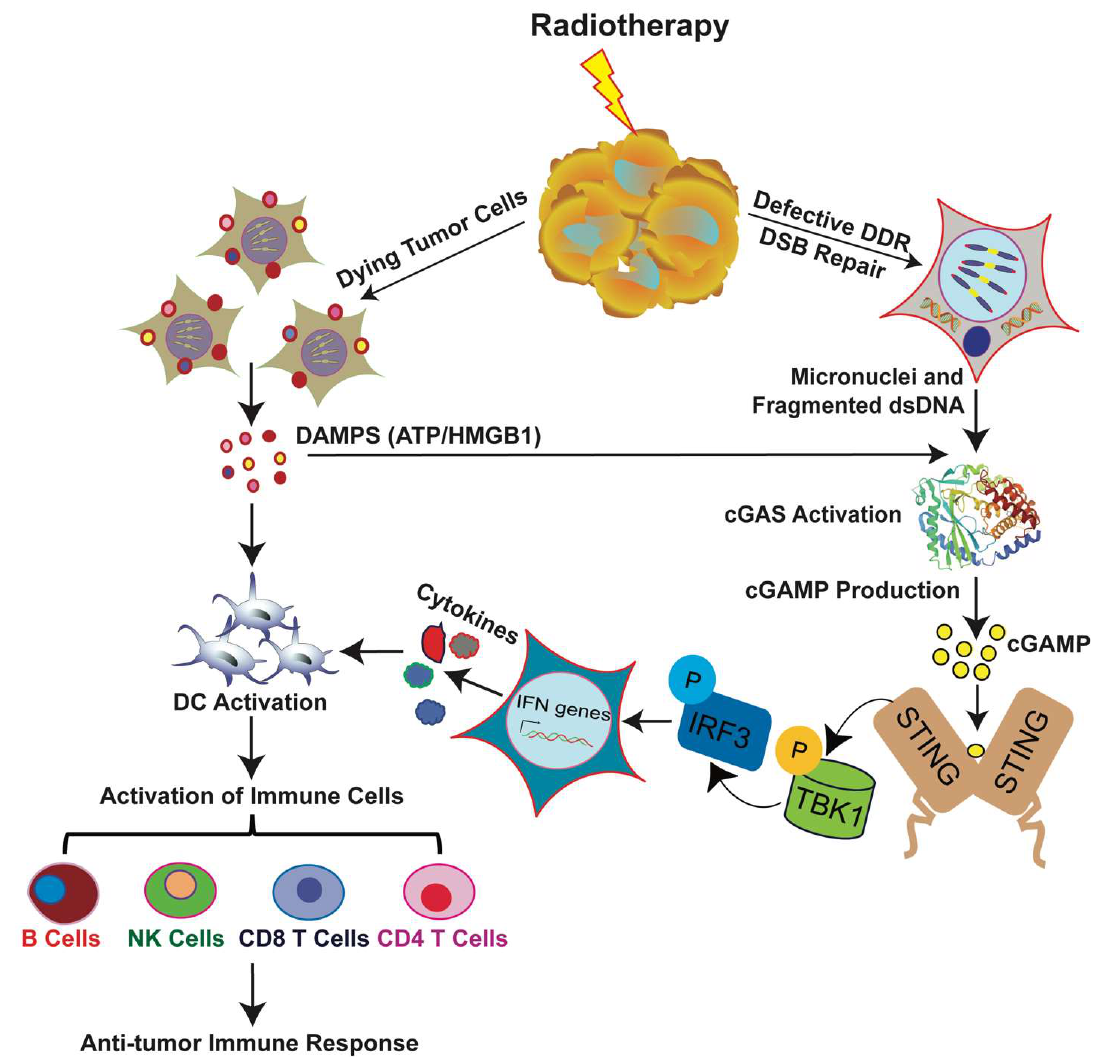
Figure 3. Schematic representation of a working hypothesis on the immunomodulatory role of radiation. Radiation induces DNA damage and generates micronuclei and fragmented dsDNA. During phagocytosis of tumor cells by dendritic cells (DCs), the DNA fragments hidden in irradiated tumor cells are released from phagosomes into the cytoplasm, where they act as a “danger signal”. The DNA sensor cGAS recognizes this signal, becomes catalytically active, and forms cGAMP. cGAMP binds to STING, which in turn activates IRF3 to induce type I IFN production. Type I IFN signaling activates DCs and promotes CD8 + T cell priming, which leads to tumor control. Alternatively, RT induces dying tumors to express more tumor antigens on their surface and to release danger-associated molecular patterns (DAMP), such as ATP and HMGB1, that stimulate DC activation. DCs express tumor antigen on their surface, interact with the T cell receptors on CD4 + /CD8 + T cells, and activate immune cells that mediate tumor-specific killing.